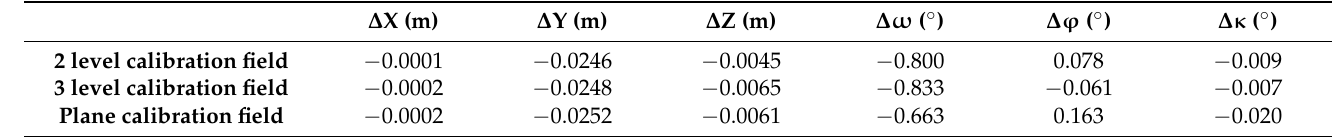
Table 6. The resulting parameters ∆ X, ∆ Y, ∆ Z, ∆ ω , ∆ ϕ , and ∆ κ .